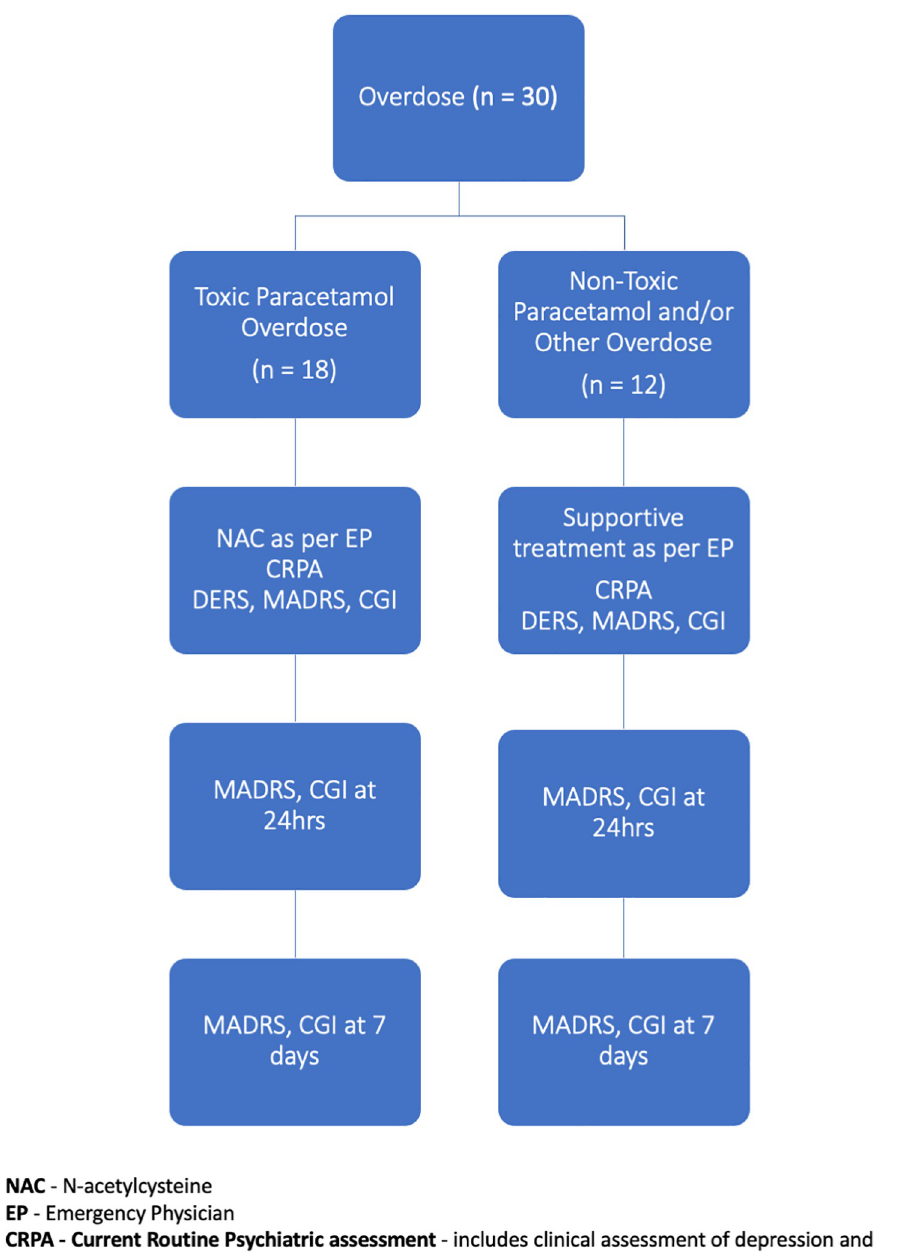
Fig 1. Study design and management of patients presenting to ED following intentional overdose.